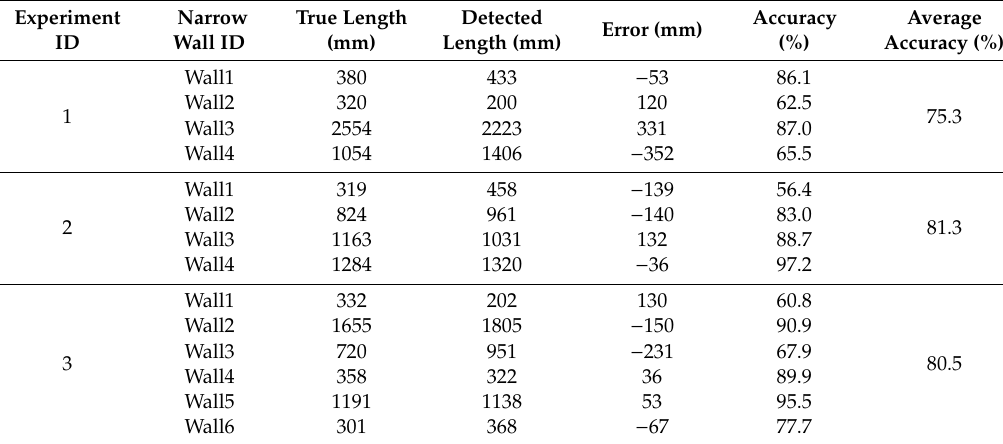
Table 5. Quantitative analysis of measured “narrow”